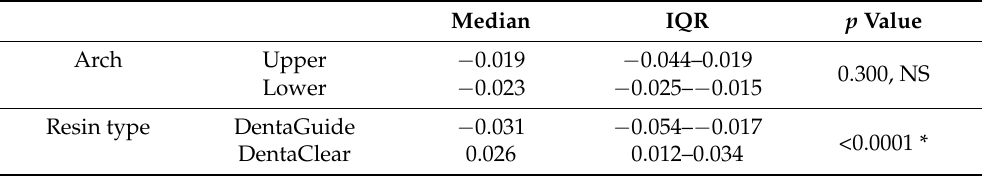
Figure 4. Measurement set-up using the coordinate measuring machine (CMM). Hole 1 is the datum where X, Y, and Z will be zero. X-axis is defined along the line centre to centre of hole 1–6 for consistency. Datum plane is defined as the surface of the guide around hole 1, describing the X–Y plane. Table 3. Results from Mann–Whitney U test for median (trueness) and interquartile range (IQR) (pre- cision) of arch and resin type compared to the STL reference image measurements. All measurements are in millimetres.